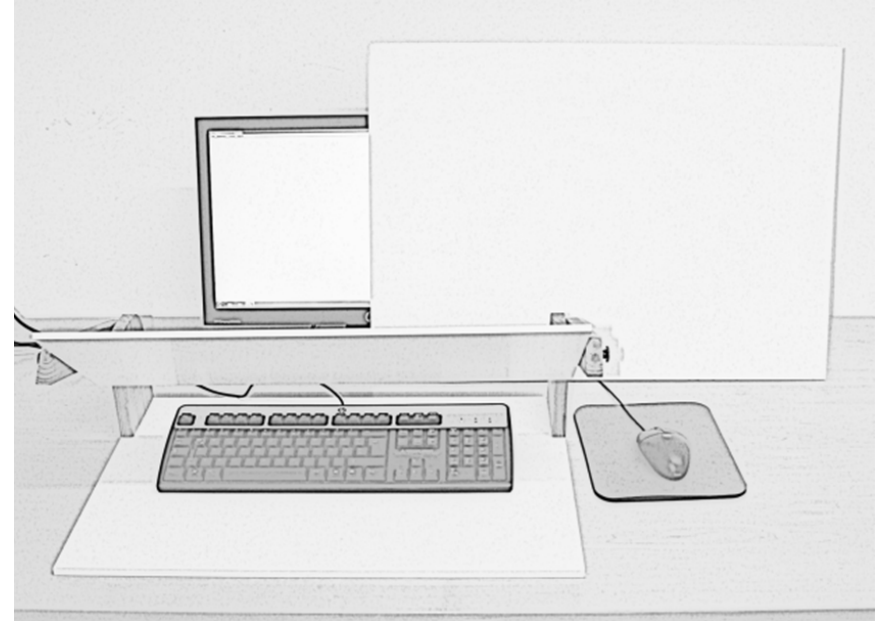
Figure 2. Illustration of the experimental setup. To manipulate visual feedback from the fingers and the keyboard, a wooden board was adjusted so that the fingers and the keyboard were either visible (as depicted) or not. To manipulate visual feedback from the screen, a piece of cardboard was placed either beside the screen or in front of the screen.